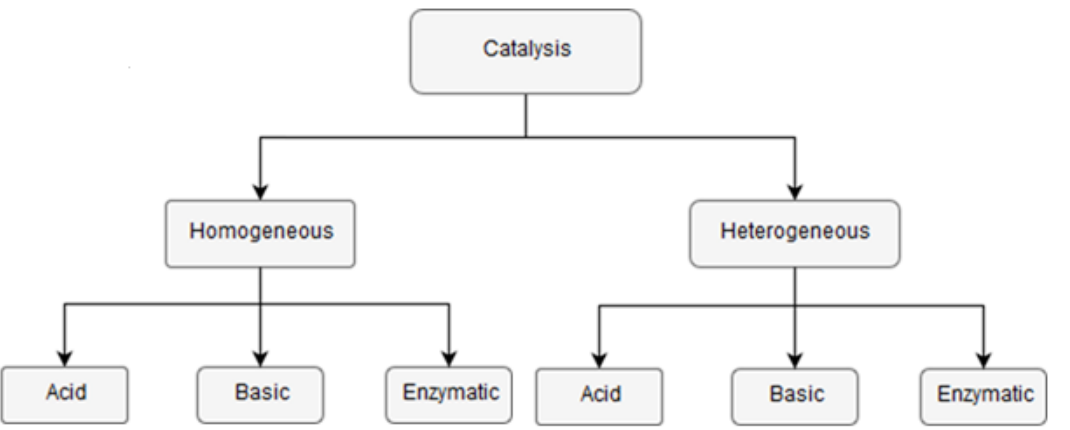
Figure 9. Different types of catalysis employed in the transesterification process.